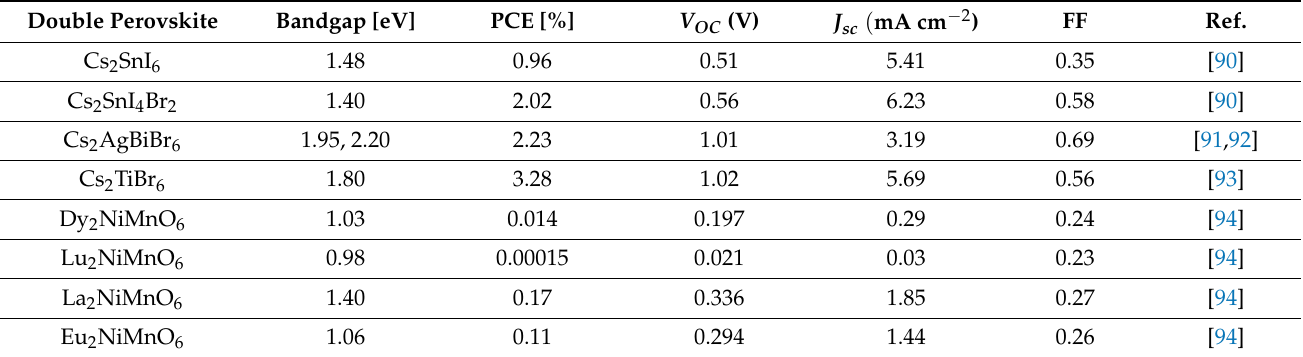
Table 3. Double-perovskites with their bandgaps and performance characteristics. Double Perovskite Bandgap